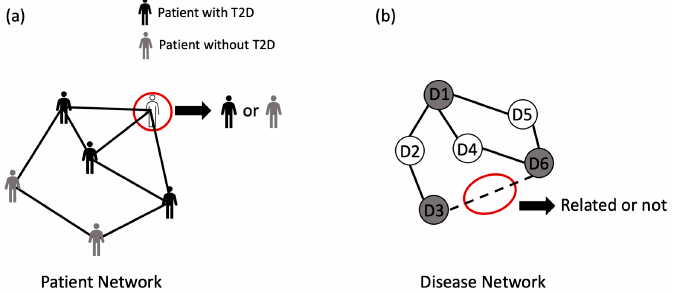
Figure 7. Examples of graph machine-learning tasks in two levels. ( a ) Node classification: the pre- diction of Type 2 diabetes (T2D) in the Patient Network. ( b ) Link Prediction: predicting the un- known link between diseases and their comorbidities through the Disease Network.